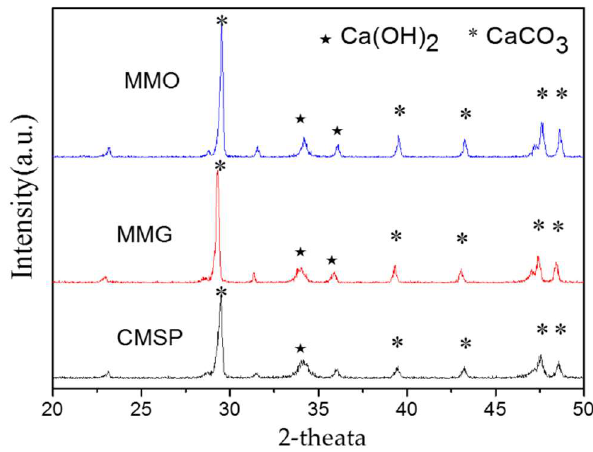
Figure 4. XRD patterns of CMSP, MMG, and MMO.